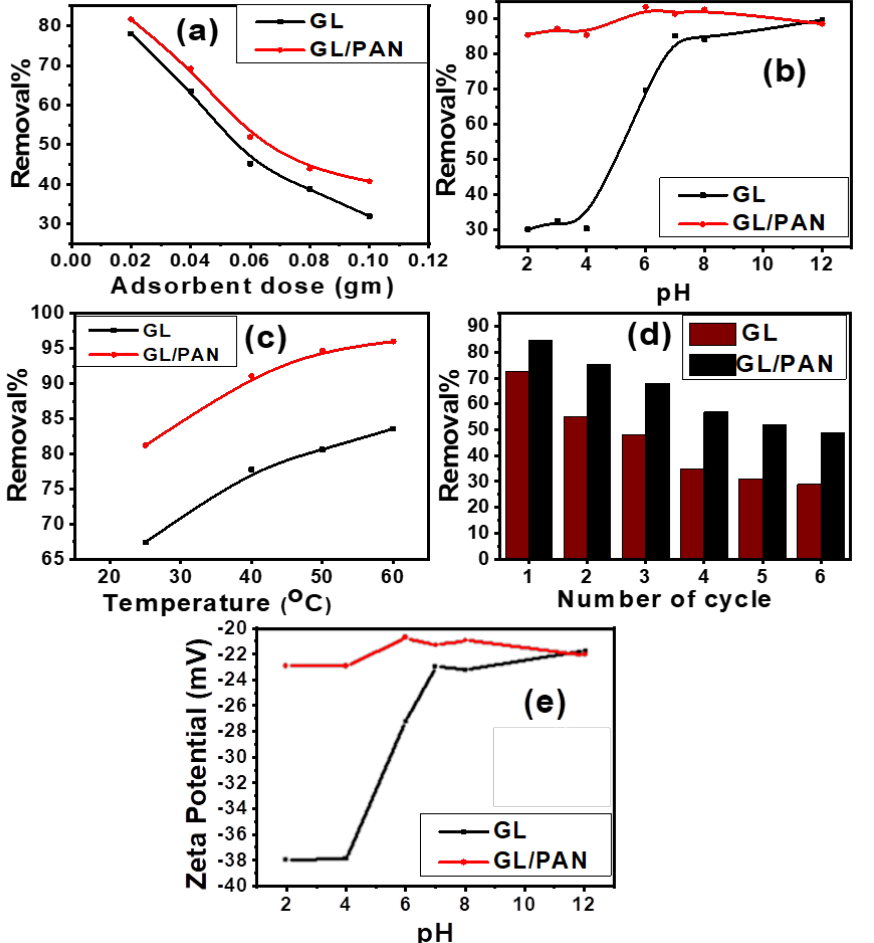
Figure 5. Effect of adsorption conditions on the removal% of CR dye (20 mL and 5 mg/L) by Gl and Gl/PAN composite: ( a ) effect of adsorbent weight; ( b ) effect of initial pH of the solution; ( c ) effect of adsorption temperature; ( d ) effect of the reusability test; and ( e ) zeta potential measurements as a function of pH for GL and GL/PAN.